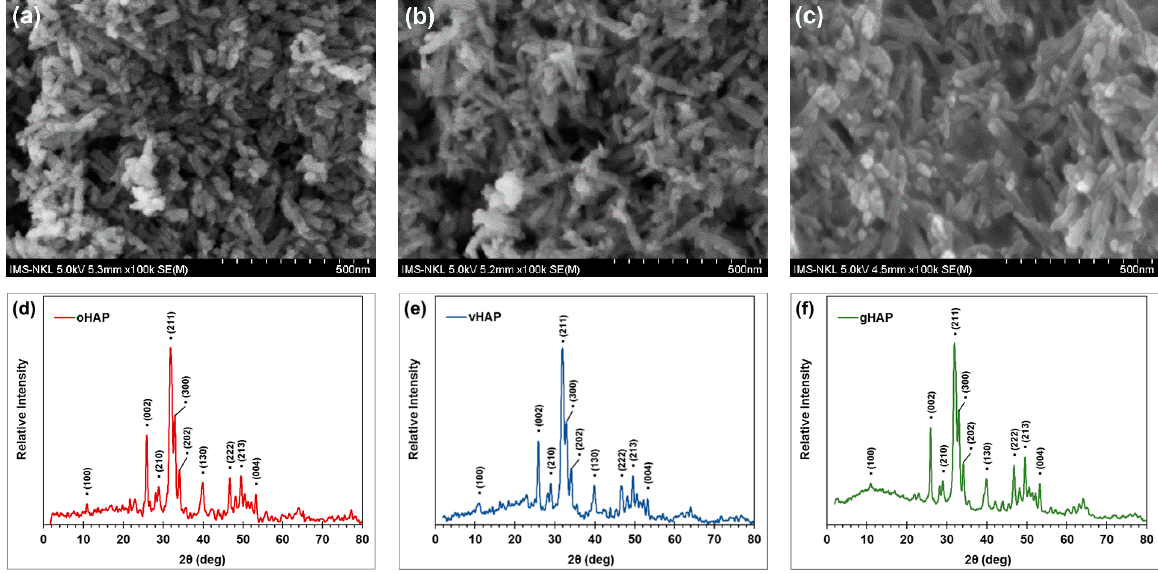
Figure 5. FESEM images of ( a ): oHAP, ( b ): vHAP, ( c ): gHAP; and XRD spectra of ( d ): oHAP, ( e ): vHAP and ( f ): gHAP.